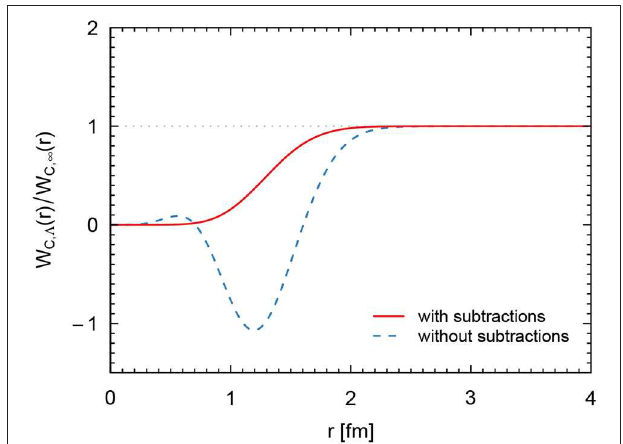
FIGURE 3 | Ratio of the regularized and unregularized central part of the leading TPEP in coordinate space for C 2 C ,1 ( µ ), C 2 C ,2 ( µ ) fixed as discussed in the C 2 C ,2 ( µ ) text and C 2 C ,1 ( µ ) 0. = =